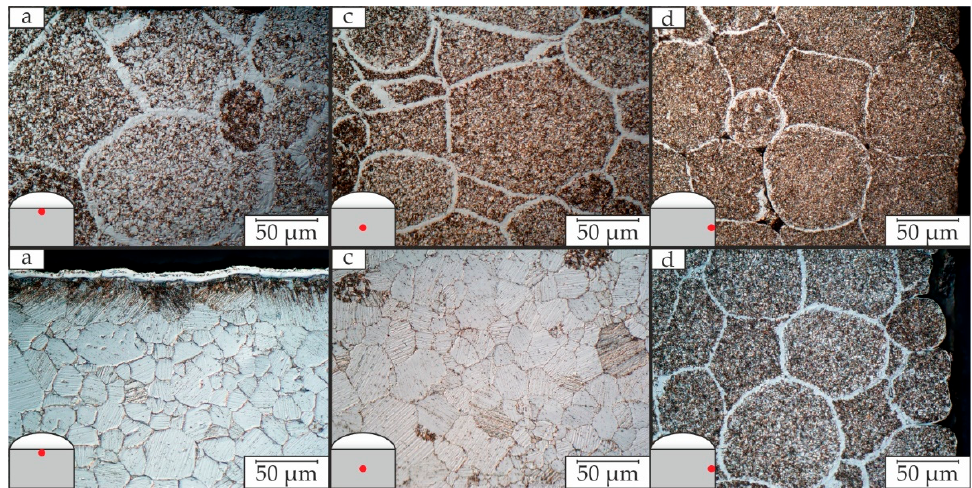
Figure 14. Microstructure in defined positions a, c and d according to Figure 1 (right) of a TNM sample sintered at 1250 °C, with 2 min dwell time and 30 MPa pressure (top) and 10 min dwell time and 65 MPa pressure (bottom).